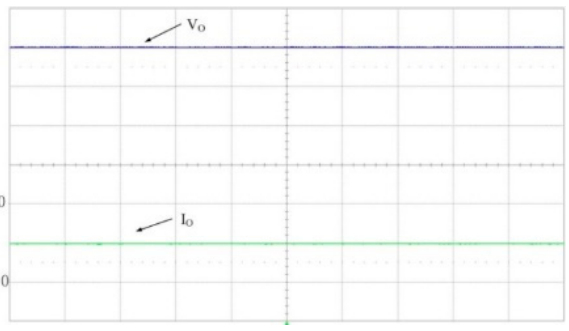
/ div, I / div, time: 5 ms / o : 0.5 A